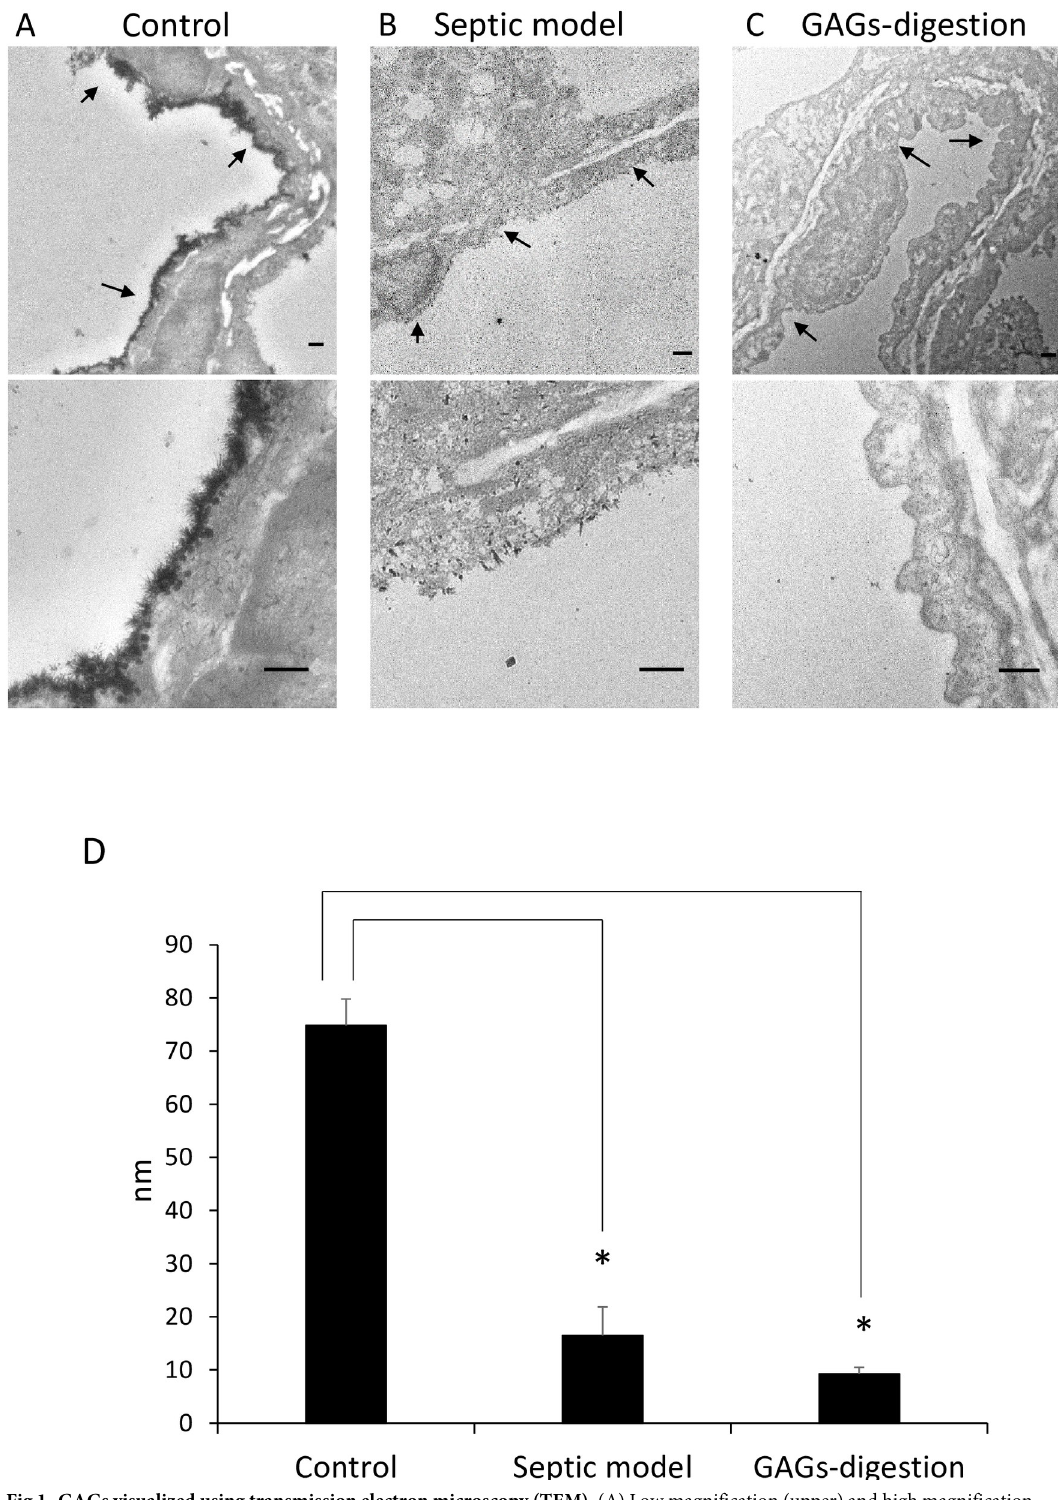
Fig 1. GAGs visualized using transmission electron microscopy (TEM). (A) Low magnification (upper) and high magnification (lower) TEM images of the lung vessels in control mice are shown. The arrows indicate lanthanum-positive GAGs in the vascular lumens. The scale bars in each image are 500 nm (n = 3 for control). (B) GAGs were absent in the septic mouse model, compared with the control mice. The arrows indicate the vascular lumens (n = 3 for septic model). (C) GAGs were absent in the